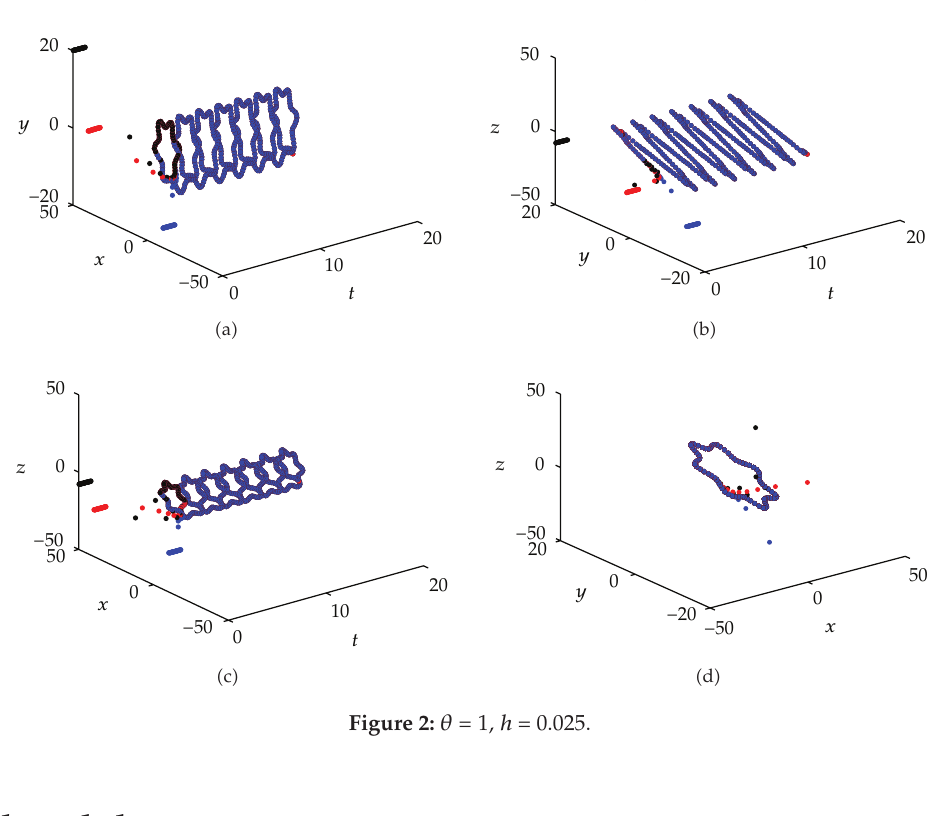
Figure 2: θ (cid:5) 1, h (cid:5)